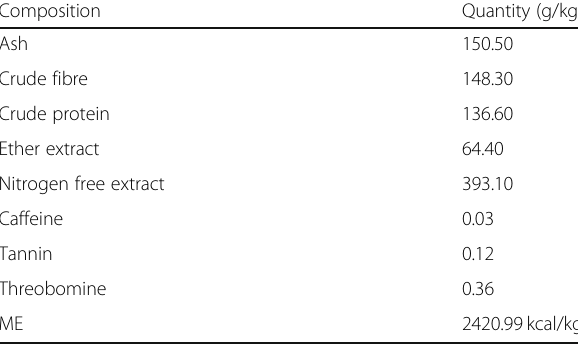
Table 3 Composition of experimental diets (finisher